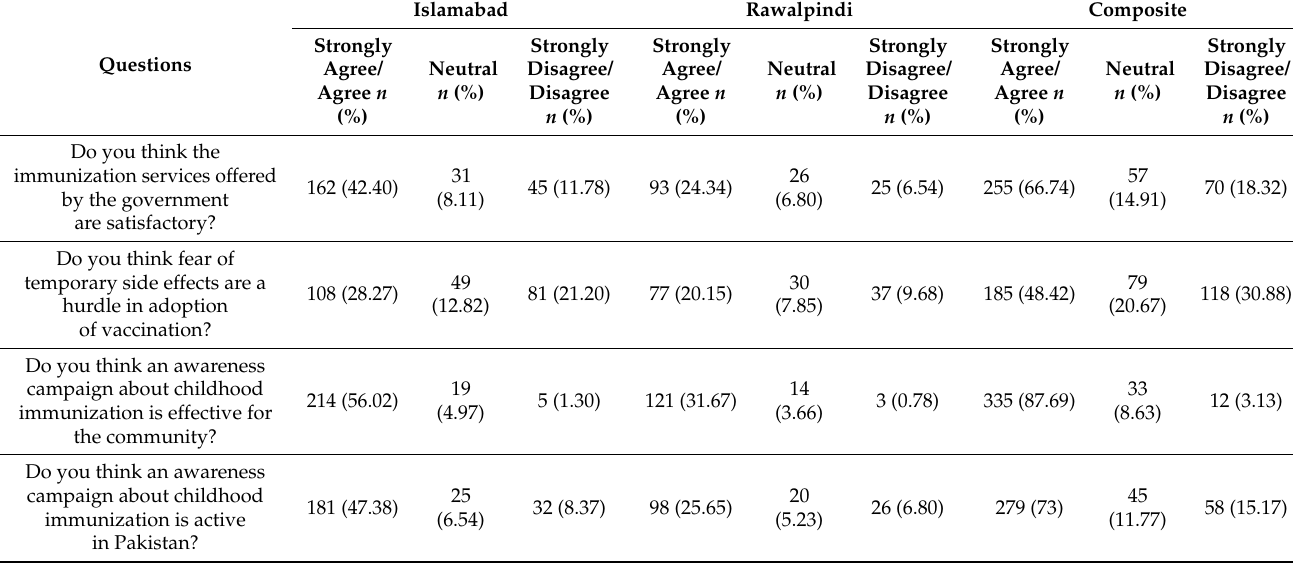
Table 3. Parents’ perceptions regarding immunization services.